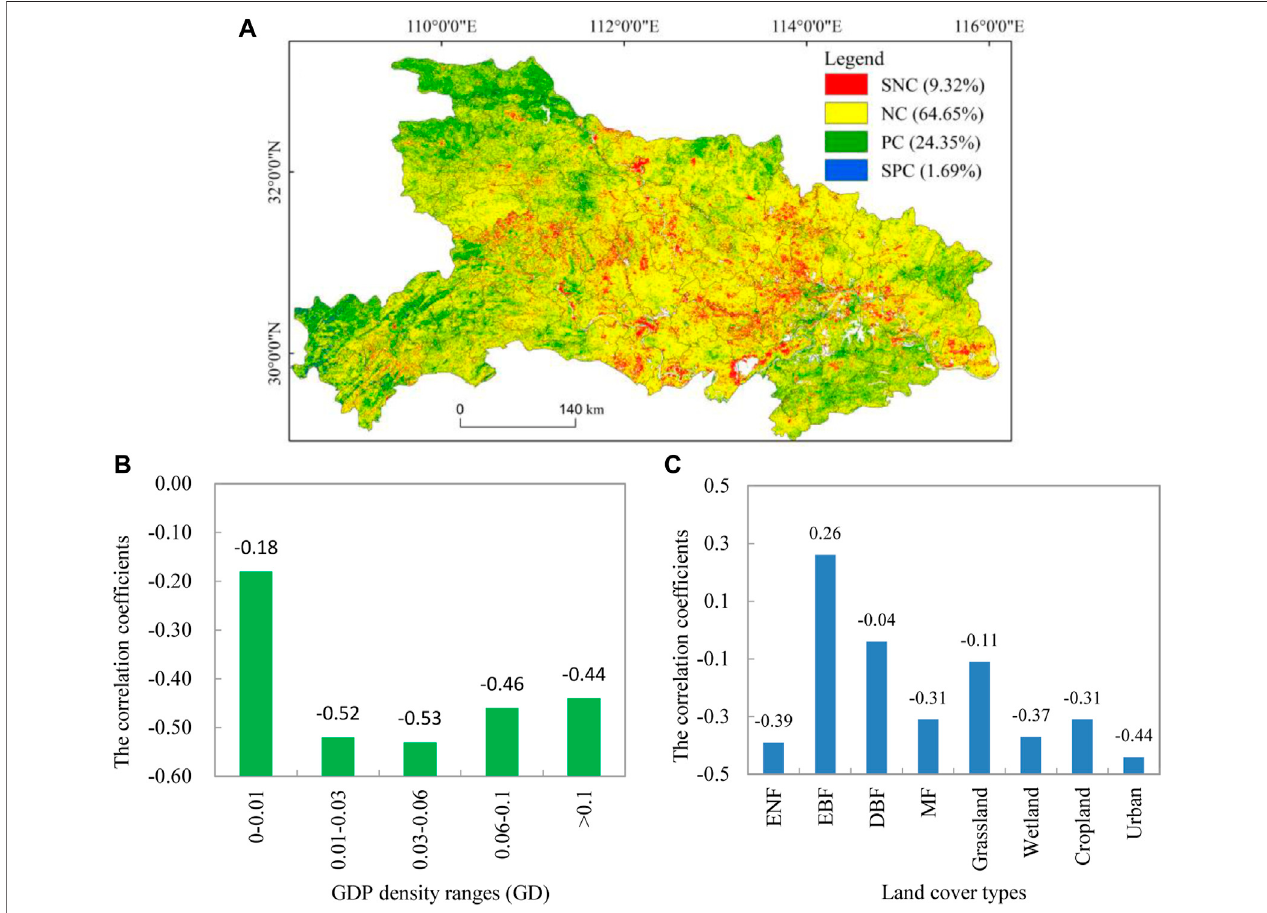
FIGURE 12 | (A) Spatial distribution of the correlations between GDP and annual NPP; (B) correlation coef fi cients between GDP and annual NPP for the different GDP density range; and (C) correlation coef fi cients between NPP and GDP for different land cover types.